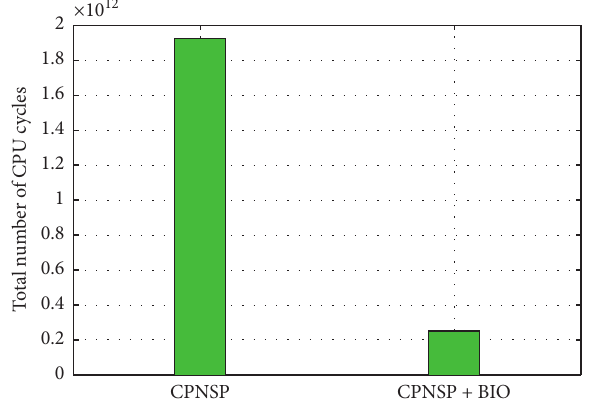
Figure 7: Total CPU cycles used in each